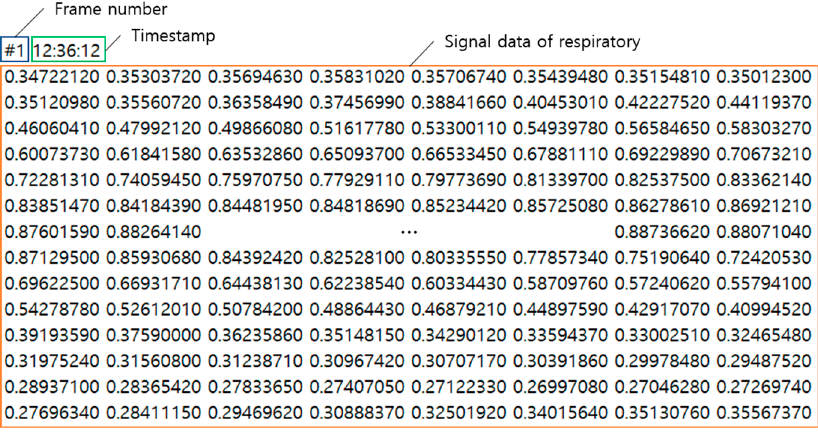
Figure 13. Breathing signal data extracted through UWB Radar.